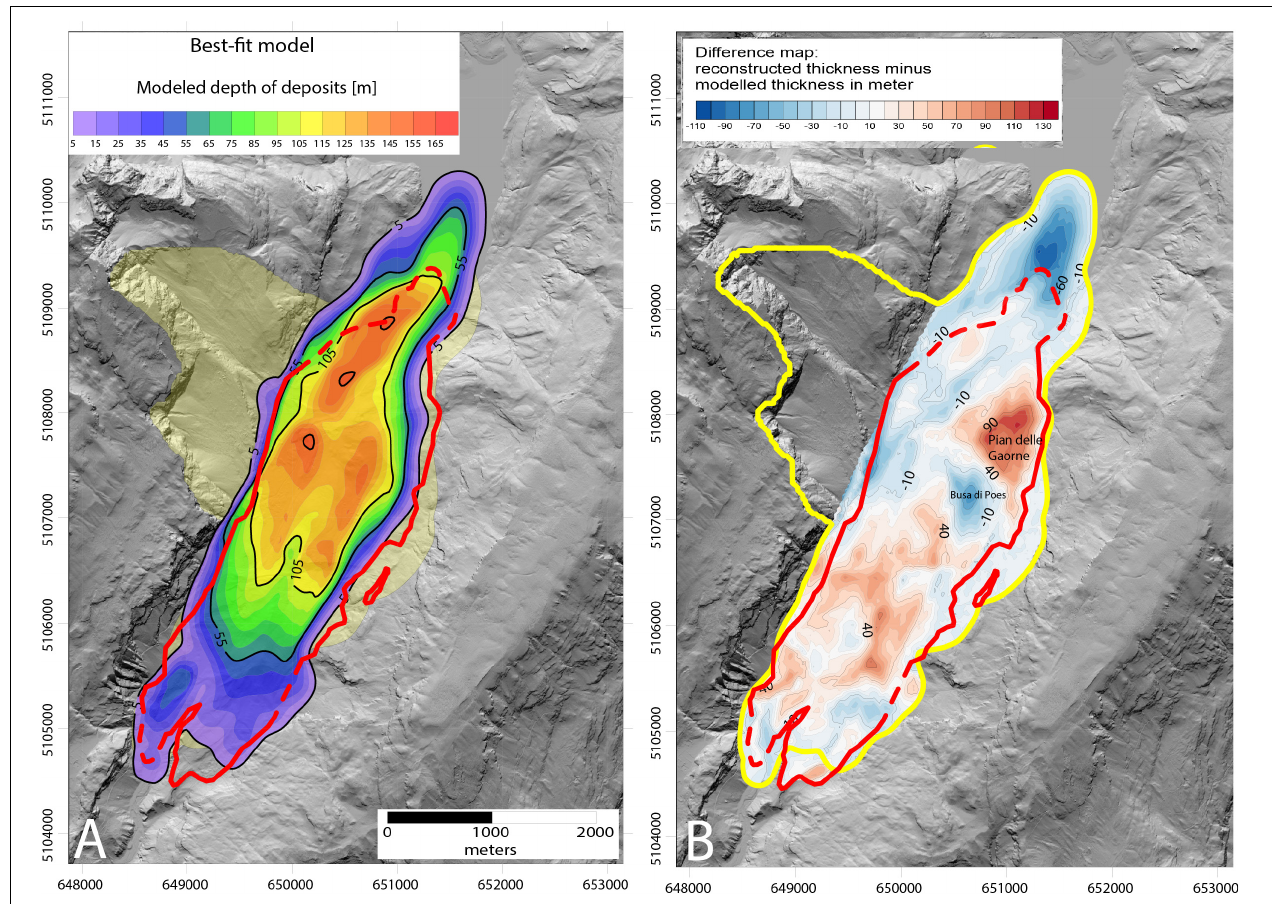
FIGURE 10 | (A) Depth map of the modeled deposits of the best-fit model. Contour interval is 10 m for the minor contour-lines and 50 m for the major contour-lines. The maximum impact area is marked in a pale yellow and the mapped landslide deposit is marked with a thick, red line. (B) Depth-difference-map between the estimated thickness when constructing the pre-failure topography and the modeled thickness of the best-fit model. The yellow outline indicates simulation results, and red indicates the mapped landslide